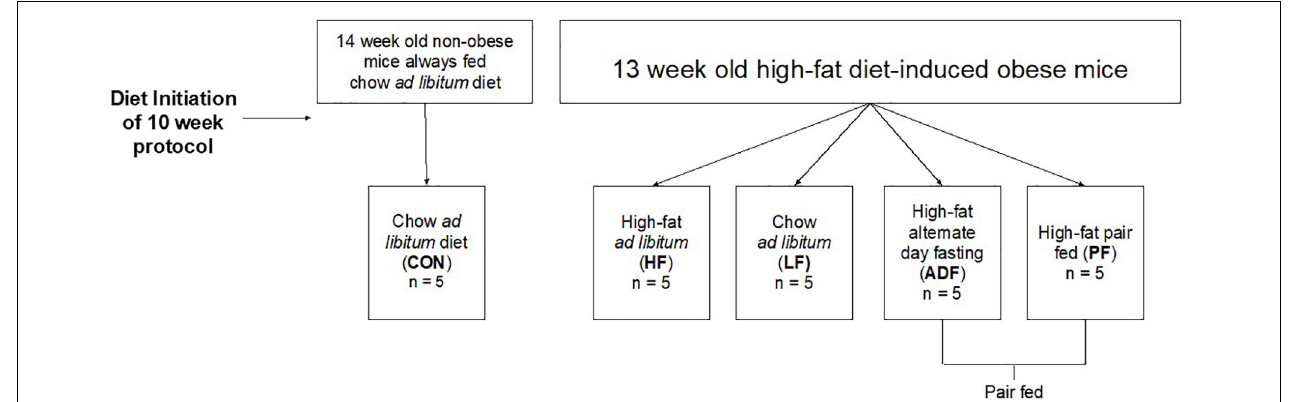
FIGURE 1 | Schematic of experimental grouping.